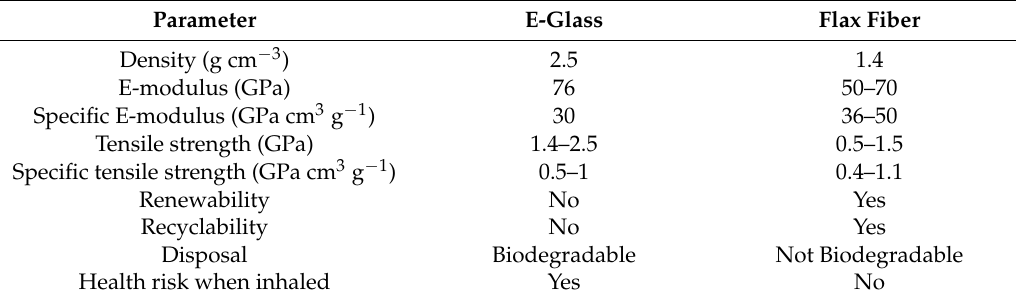
Table 1. Comparison between natural flax fiber and glass fiber. Adapted from